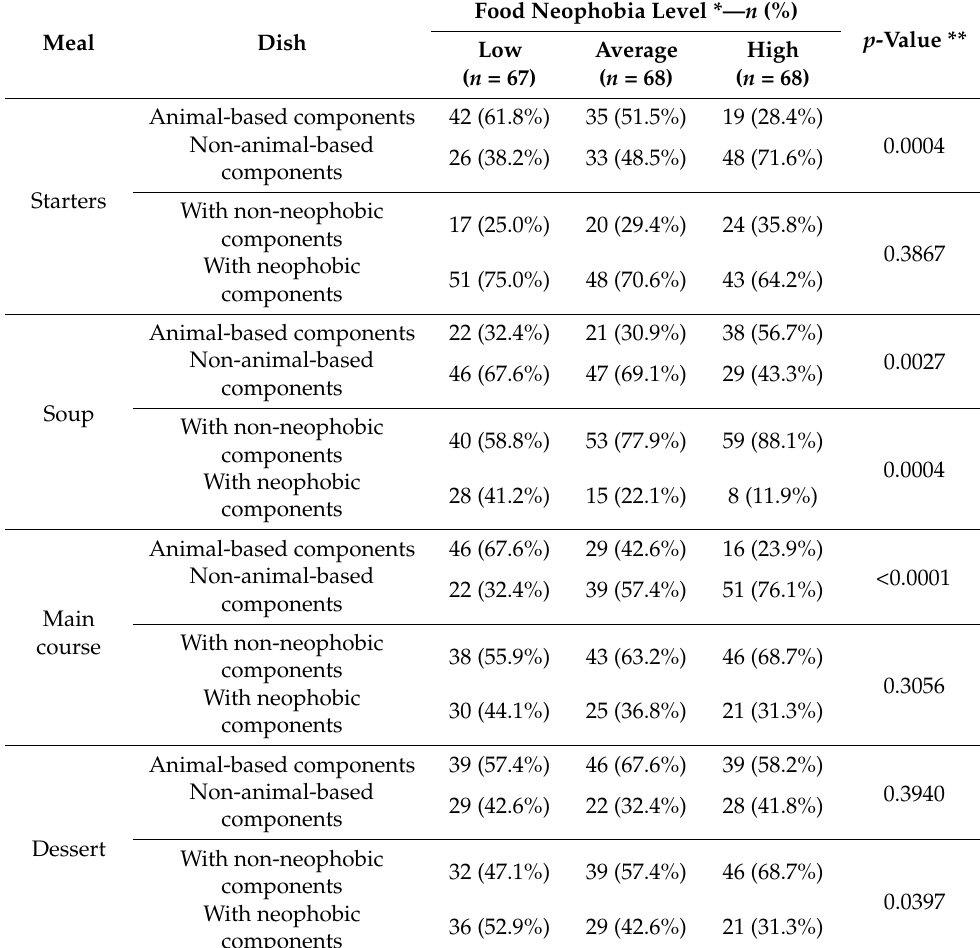
Table 6. The dish choices made by the studied sample of young Polish women from the model French restaurant menu. The dishes are organized within sub-groups of dishes containing animal-based components/non-animal-based components, or with non-neophobic components/with neophobic